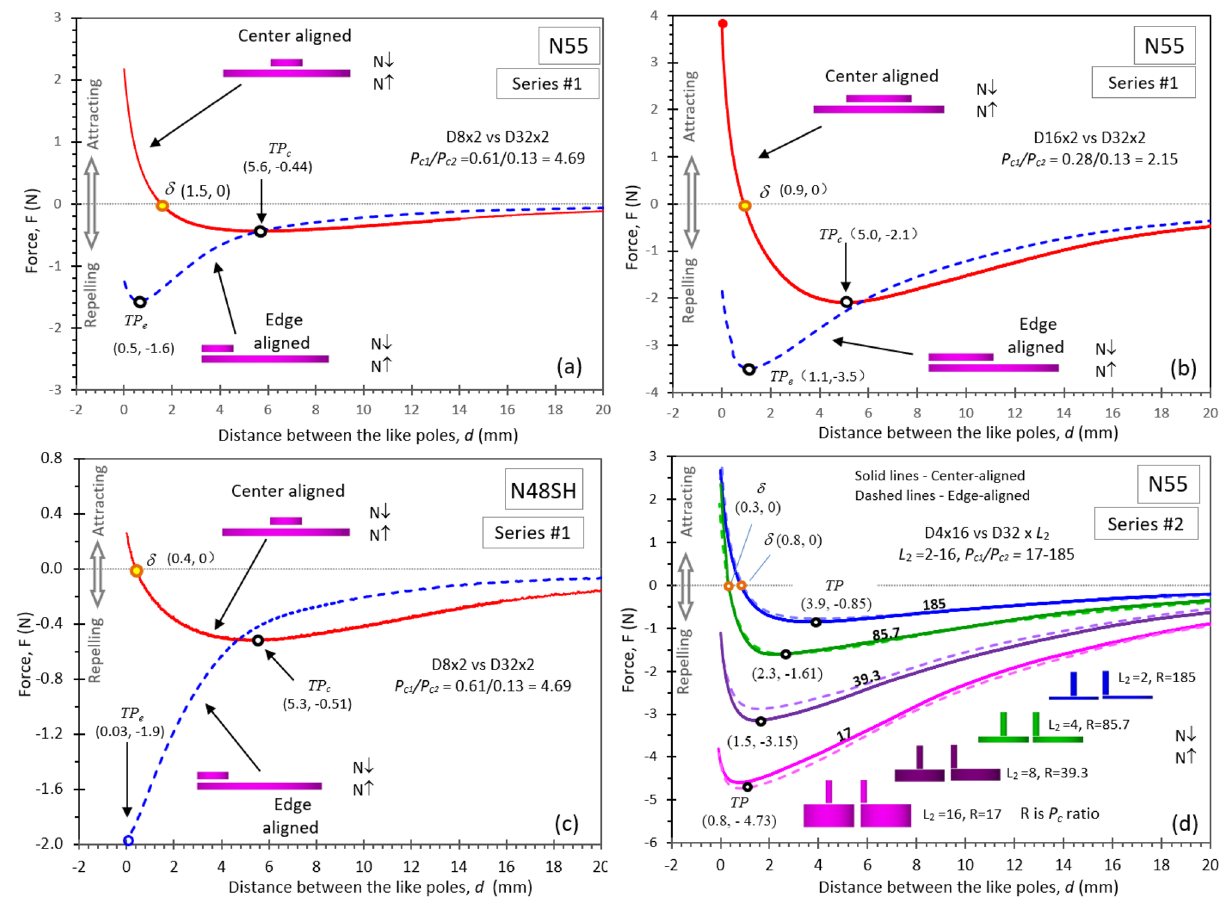
Figure 1. The curves of force vs. distance between like poles show attraction at a sufficiently small distance for NdFeB pairs. In Series #1 (thin magnet pairs), the pairs of N55 magnets with P c ratios of 10.8 (not shown here), 4.69 ( a ), and 2.15 ( b ), all show the transition from a repelling force to an attracting force for the center-aligned pairs, but such a transition is absent for the edge-aligned pairs. The N48SH pairs with P c ratios of 4.69 ( c ) and 10.8 (not shown here) also exhibit the same features as the N55 pairs. This indicates that the LD effect is stronger in the center-aligned than in the edge-aligned for the thin magnet pairs. In Series #2 (thick magnet pairs), the pairs of N55 with P c ratios of 17 to 185 show negligible force differences between the center-aligned and edge- aligned ( d ). Two pairs with larger P c ratios of 85.7 and 185 show the transition from repelling to attracting, and the other two pairs with smaller P c ratios of 17 and 39.3 do not have such a